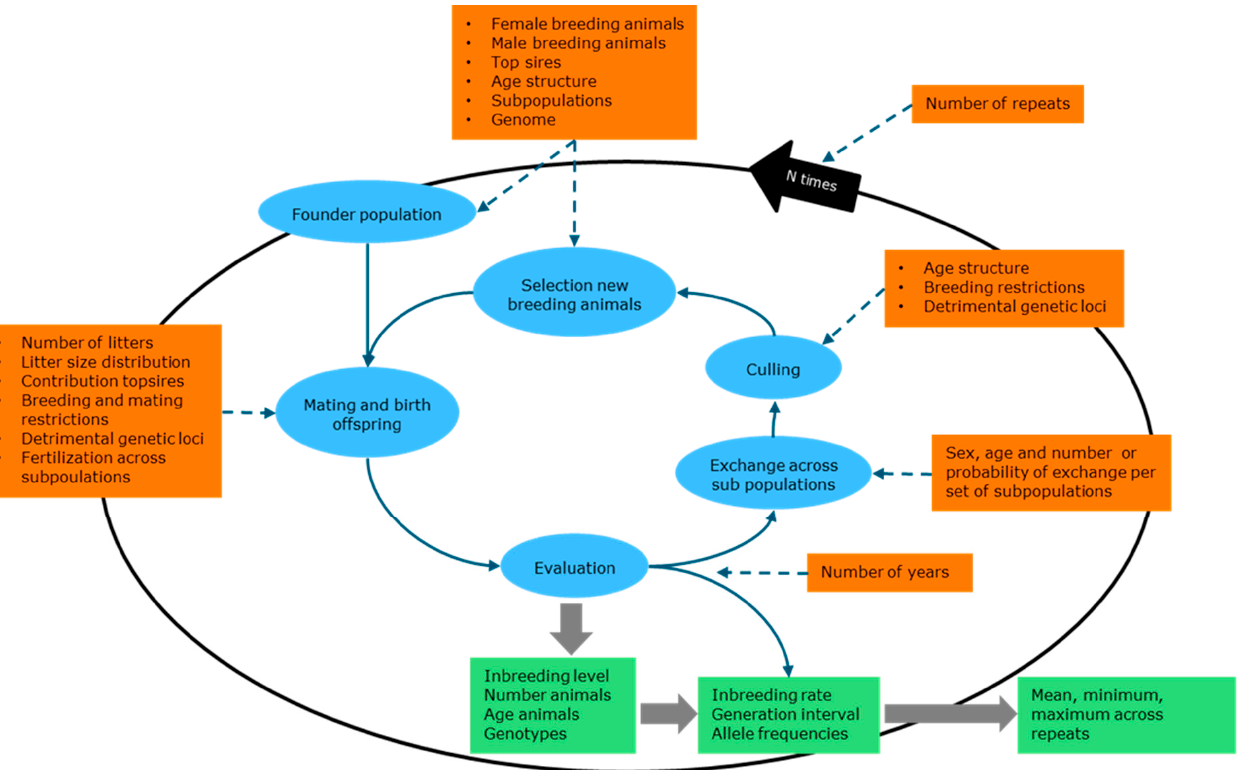
Figure 3. Set up of Pointer software for simulation of genetic management.